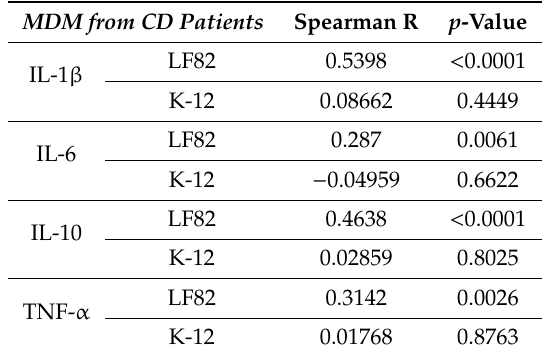
Table 3. Correlation between bacterial survival and the level of cytokines after 10 h of AIEC LF82 or E. coli K-12 infection in MDM from 95 Crohn’s disease